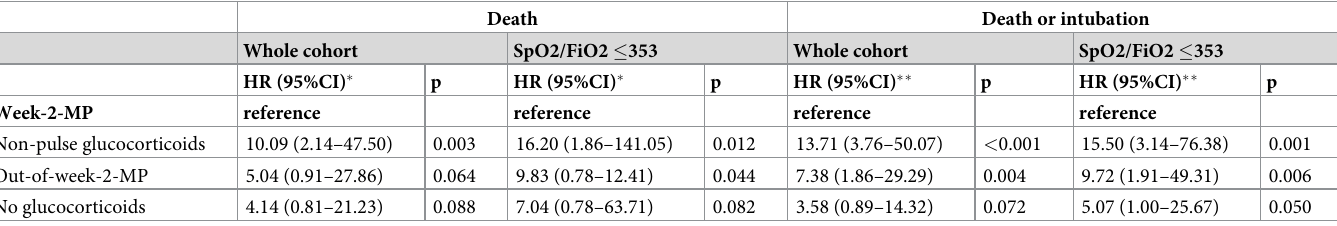
Table 7. Cox models for death and death or intubation by type of glucocorticoid